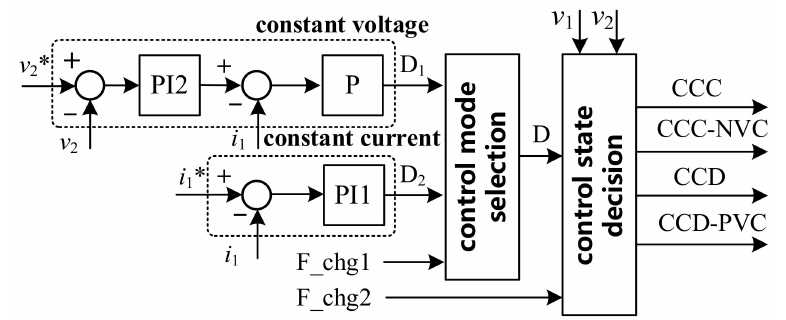
Figure 7. Charging and discharging control diagram.